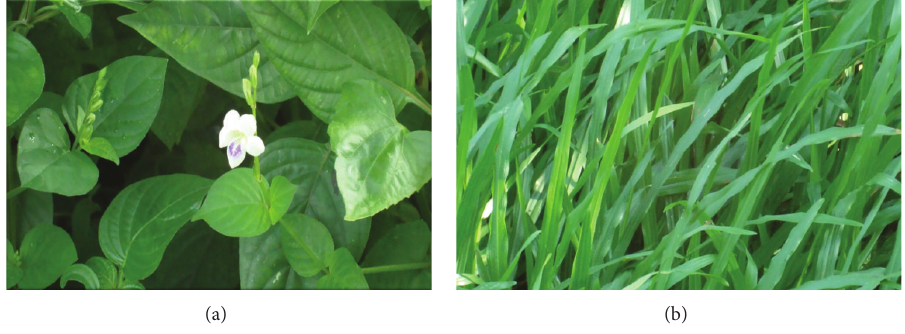
Figure 1: Asystasi gangetica (a) and Axonopus compressus